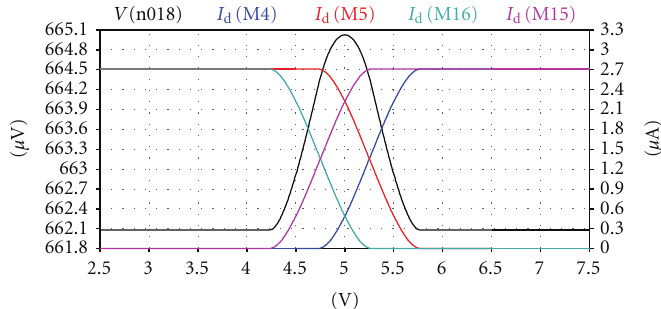
Figure 14: Gaussian-shaped membership function, V b3 = 1 . 25 V.